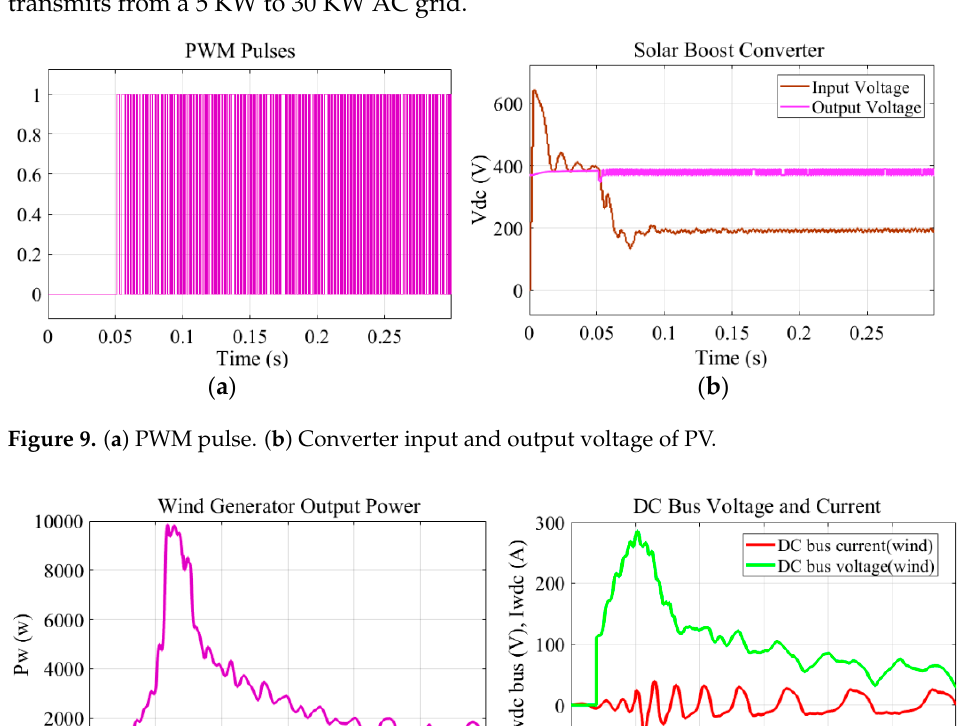
Figure 8. ( a ) Grid voltage. ( b ) Grid current.